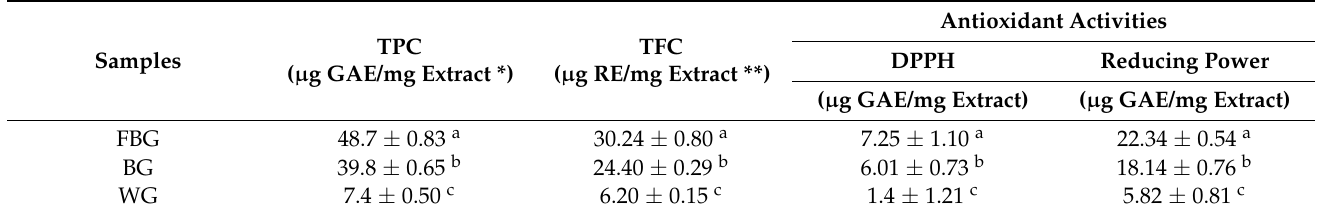
Table 3. Total phenolic content, total flavonoid content, and antioxidant activities of FBG, BG, and WG. Samples